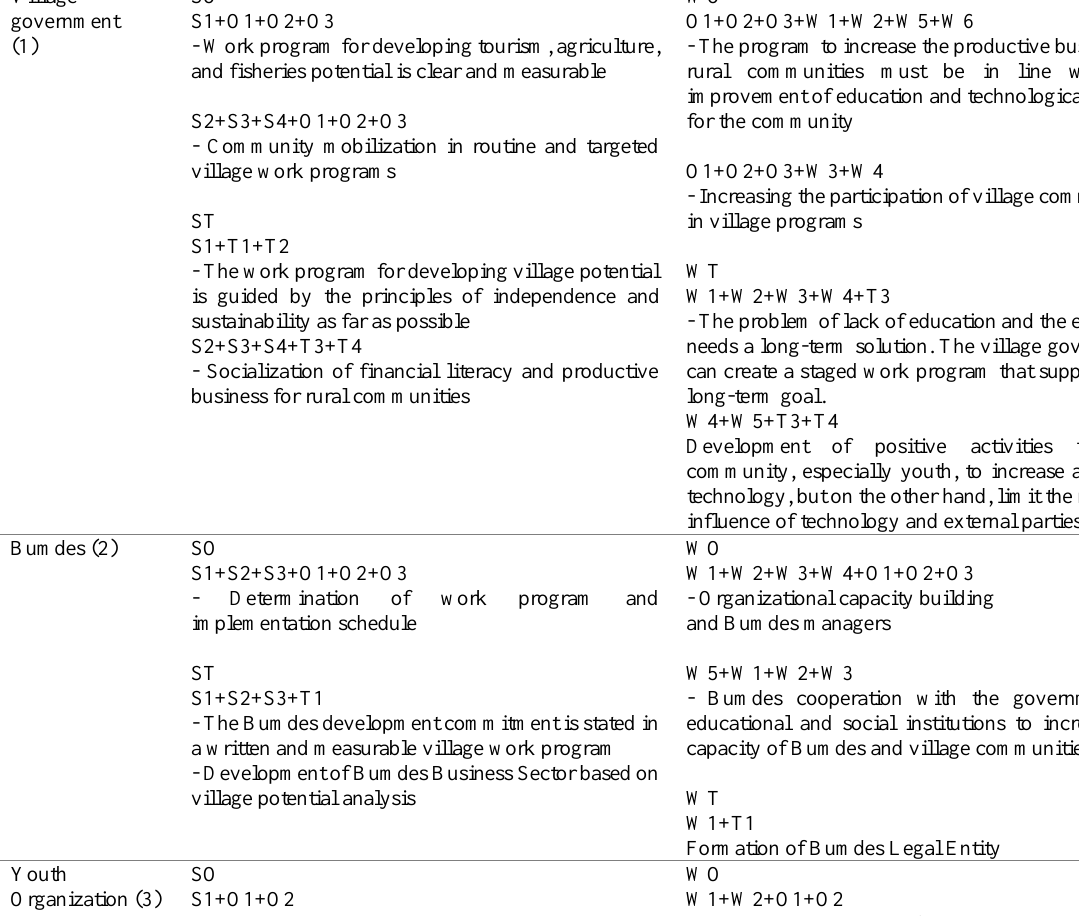
Table 4: GD Results: List of Proposed Solutions based on SWOT Analysis and Needs Village